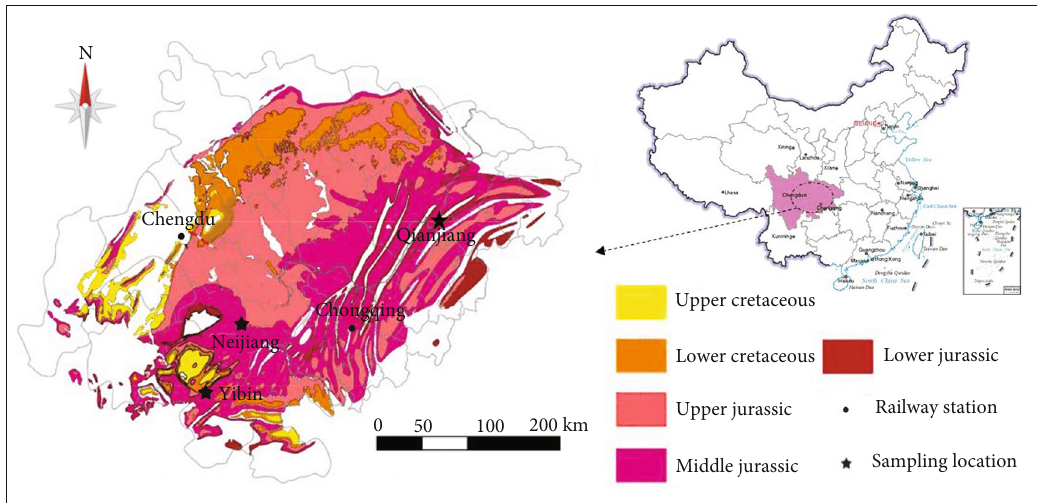
Figure 2: Spatial distribution of red mudstone in central